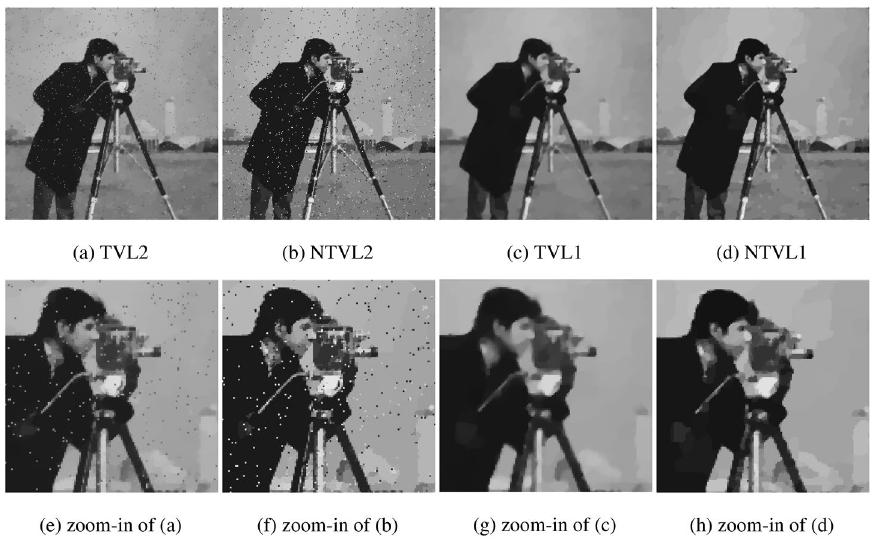
Figure 8. The denoising results of Cameraman contaminated by Gaussian noise ( σ = 0.01 ) and salt and pepper noise ( d = 0.03